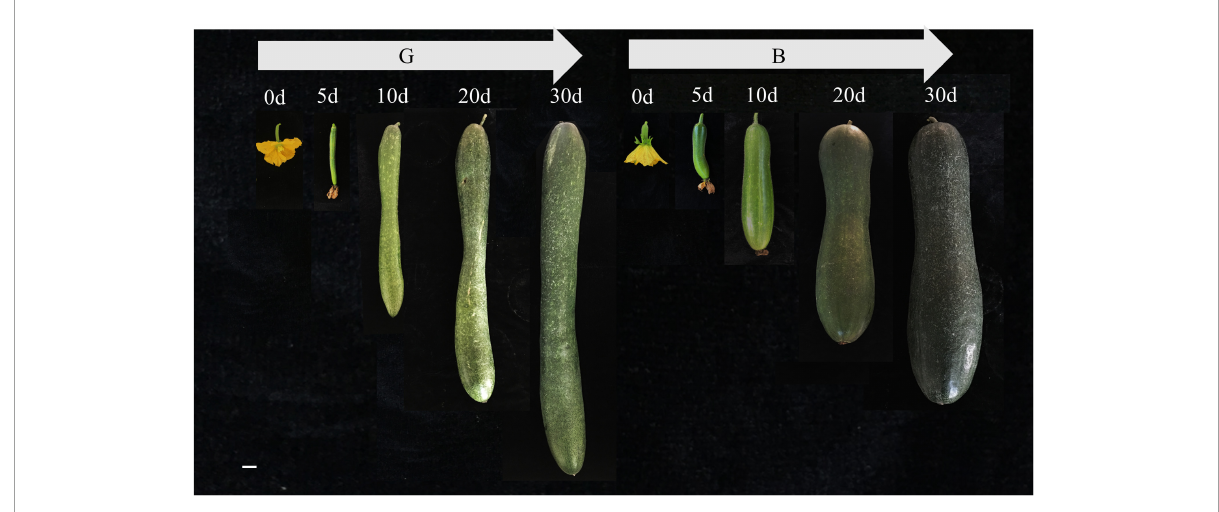
FIGURE1 The developmental process of two specific significantly different varieties (G and B) at 0, 5, 10, 20, 30 days after pollination, respectively. Bar = 3